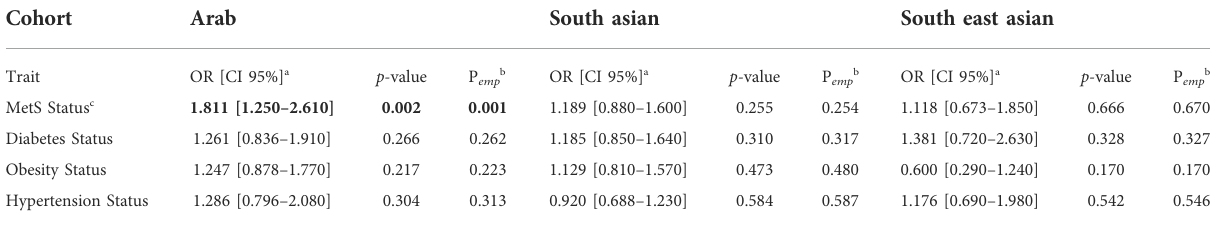
TABLE 4 Summary statistics of dichotomous traits association with rs1997623_A in Arab, South Asian and South East Asian cohorts using logistic regression adjusted for Age and Sex.